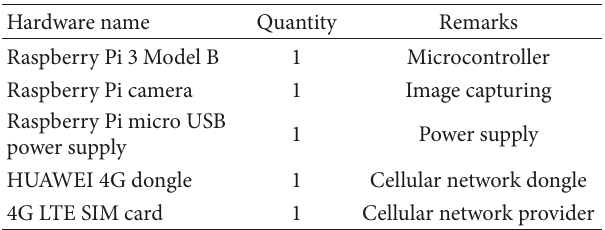
Table 2: Hardware components.